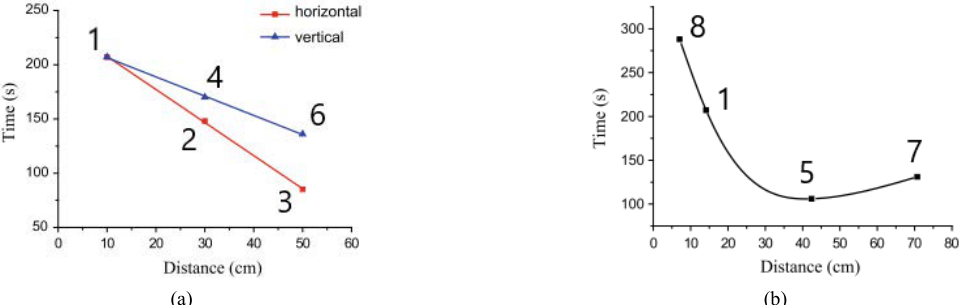
Fig. 11 (a) The variation of breakage time for both horizontal and vertical changes in location and (b) the variation of breakage time for diagonal changes in location (Wang